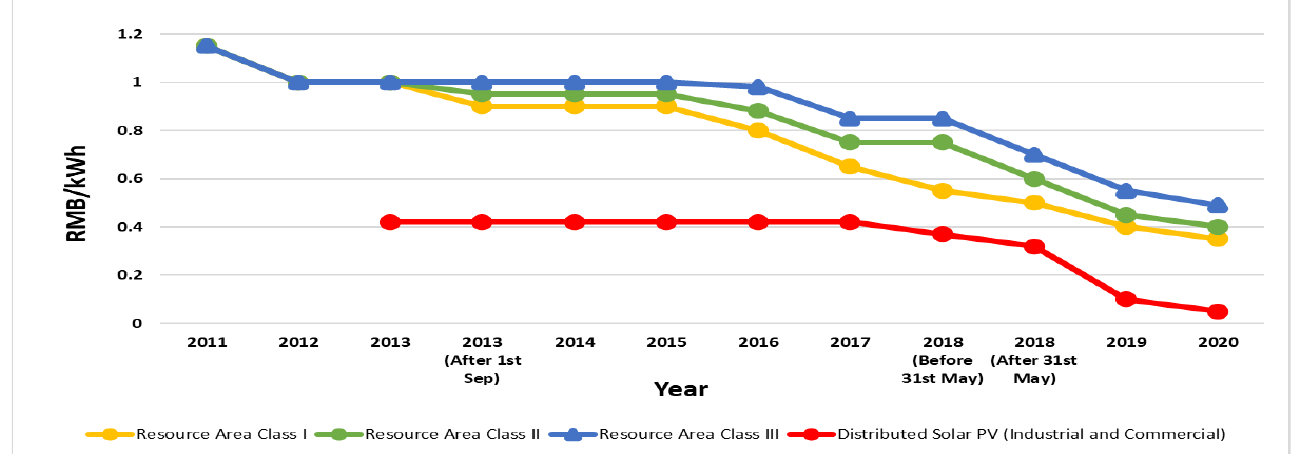
Figure 2. Feed-in tariff rates for solar PV power in China. Notes: Based on annual equivalent utilization (AEU) hours of solar energy, China divided distinct locations into three broad categories of “resource areas”, each applying a specific level of on-grid tariff. Class I refers to those areas with 1600 AEU hours; Class II refers to those with 1400–1600 AEU hours; and the remaining areas belong to Class III. Source: Shui (2020) [39].